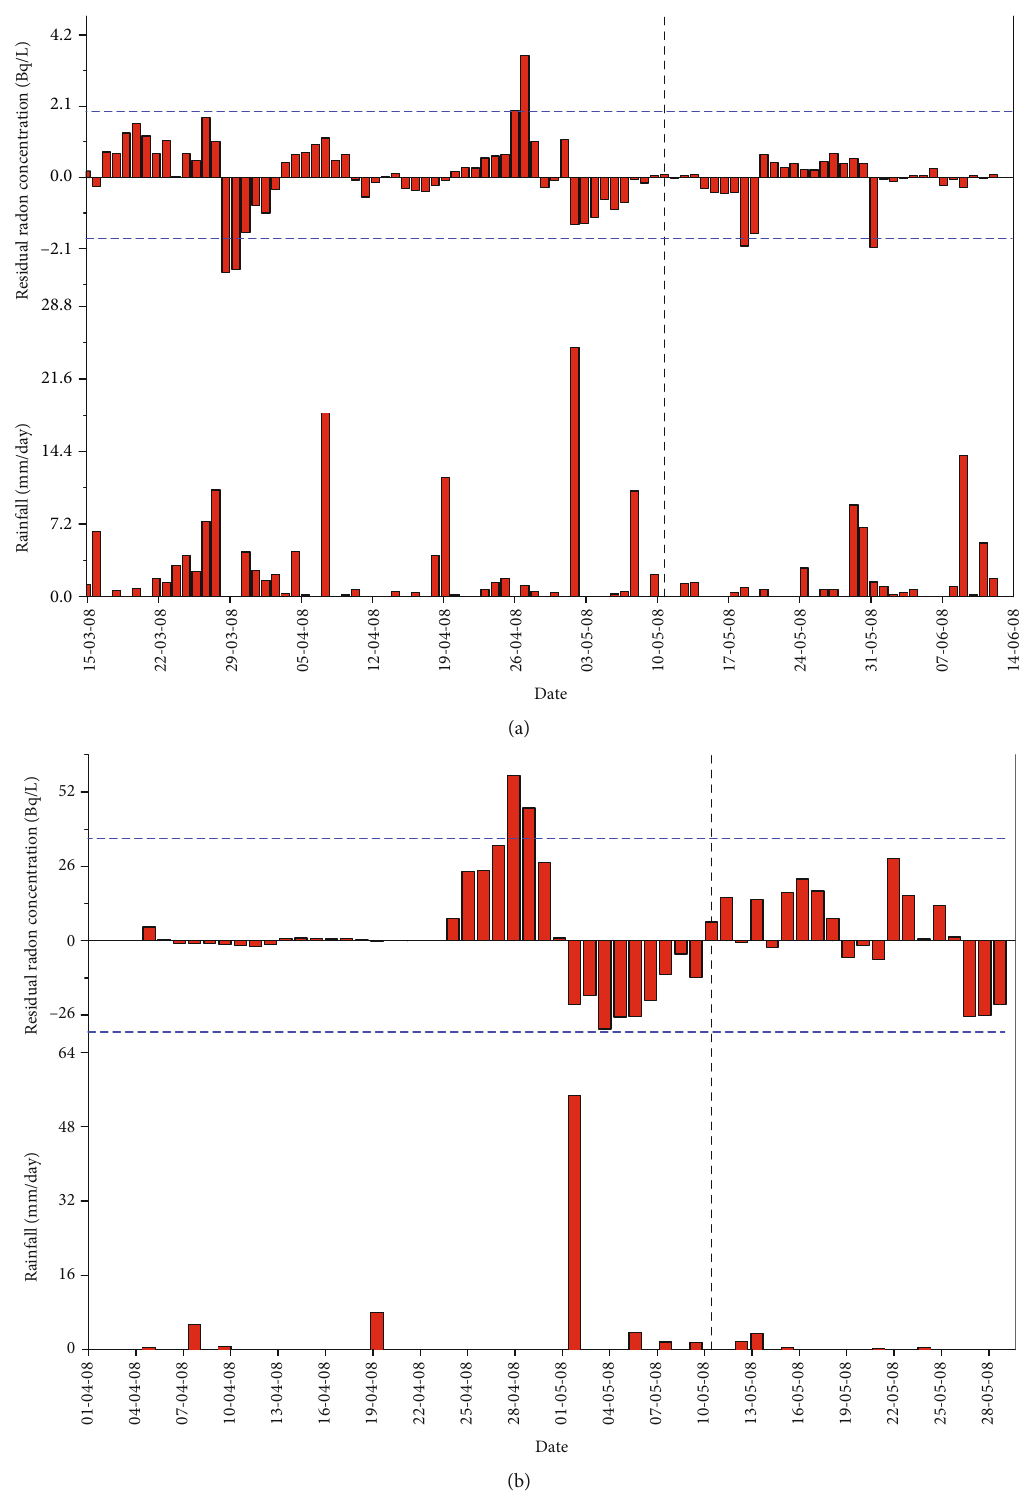
R : 3 : The inspection of the E / D > 0